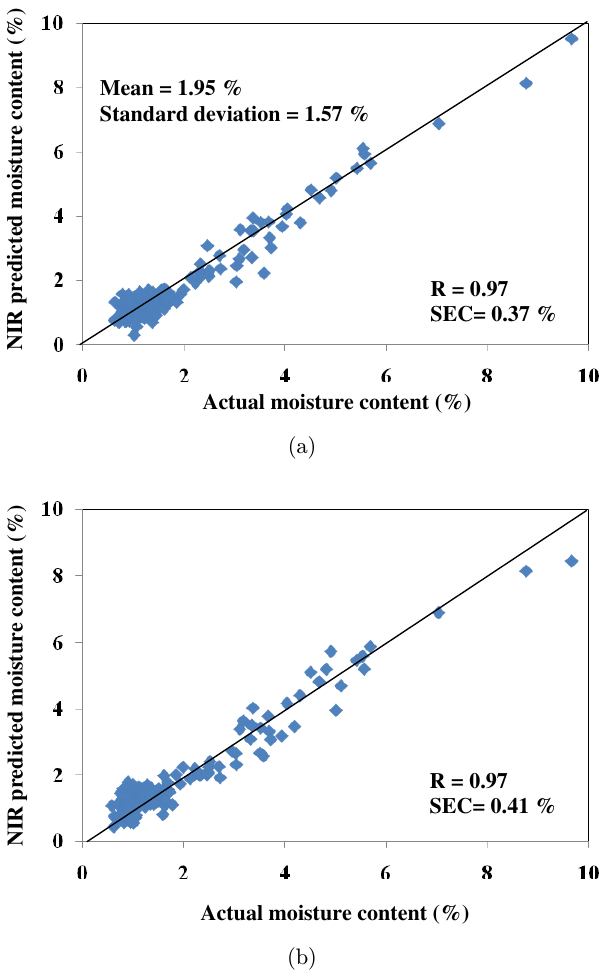
Fig. 4. Scatter plots of single sheet system (a) and a pile of sheet system (b) in the calibration